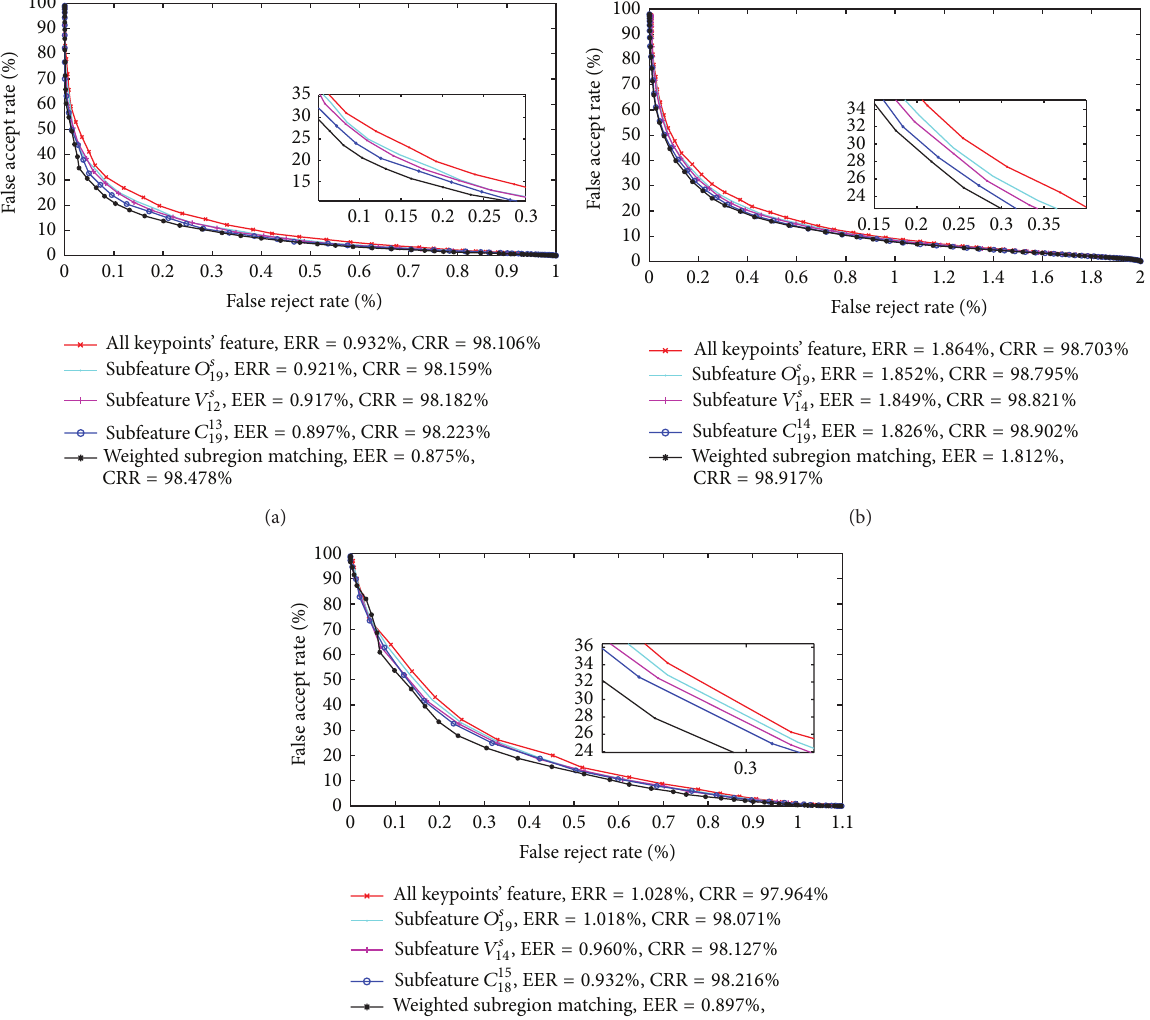
Figure 18: ROC curves of all keypoints feature and three subfeature selection strategies and weighted matching method. (a) ROC curve for CASIA-V3 Interval, (b) ROC curve for CASIA-V3 Lamp, and (c) ROC curve for